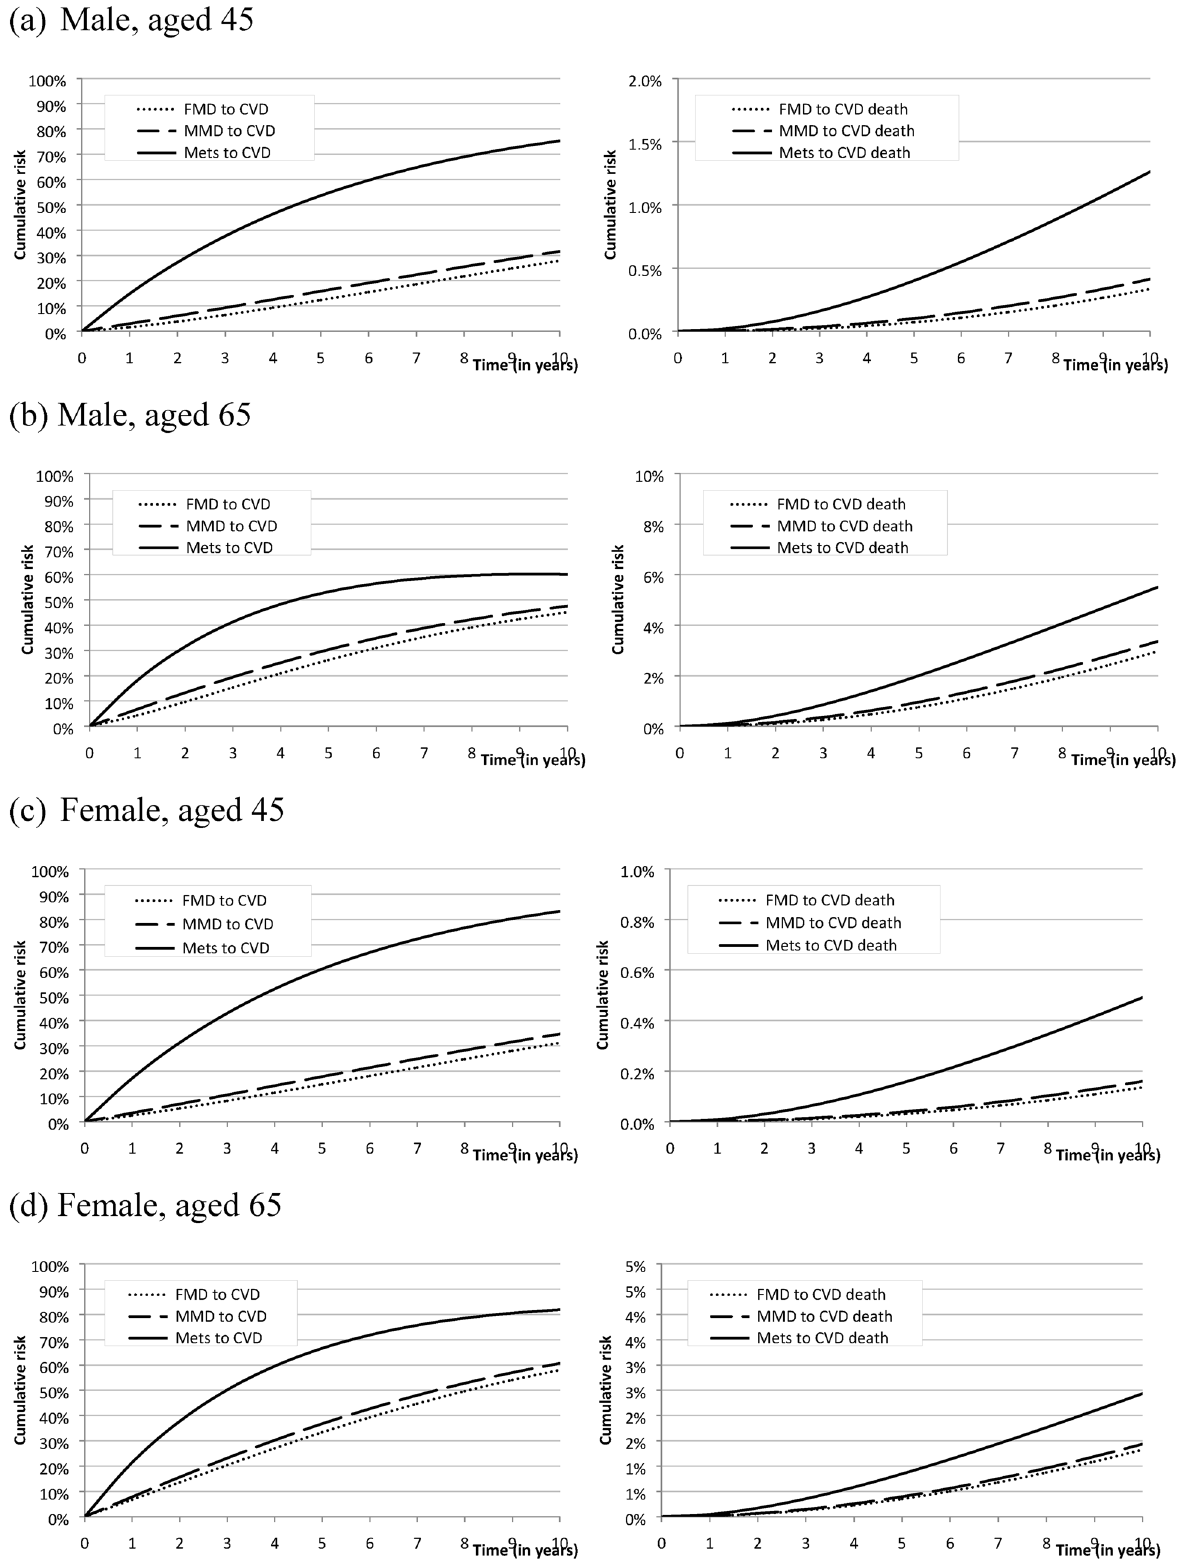
Figure 3. Cumulative risk of developing CVD and CVD death by different level of metabolic disorder for hypothetical male and female cases aged 45 and 65